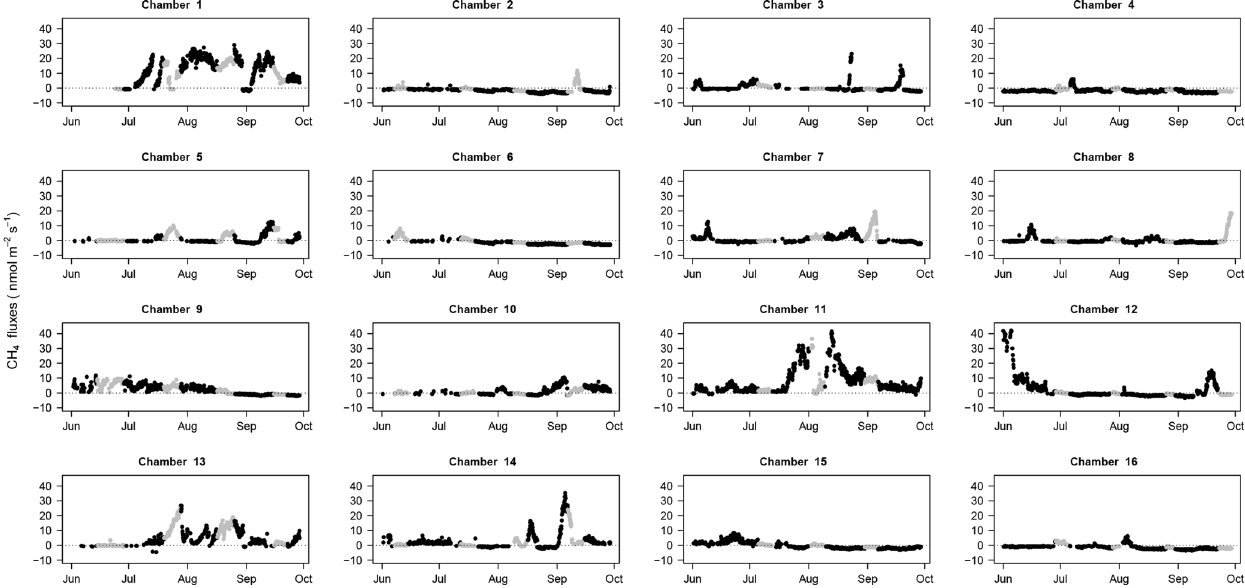
Figure 6. CH 4 fluxes through time: CH 4 fluxes for each chamber (1 to 16) over the study period with fluxes estimated with a SHORT (2min) closure time in black and fluxes estimated with a LONG (25min) closure time in grey. The dotted line displays the zero flux line. All panels have the same limits on the y axis (from − 5 to 30nmolm − 2 s − 1 ).